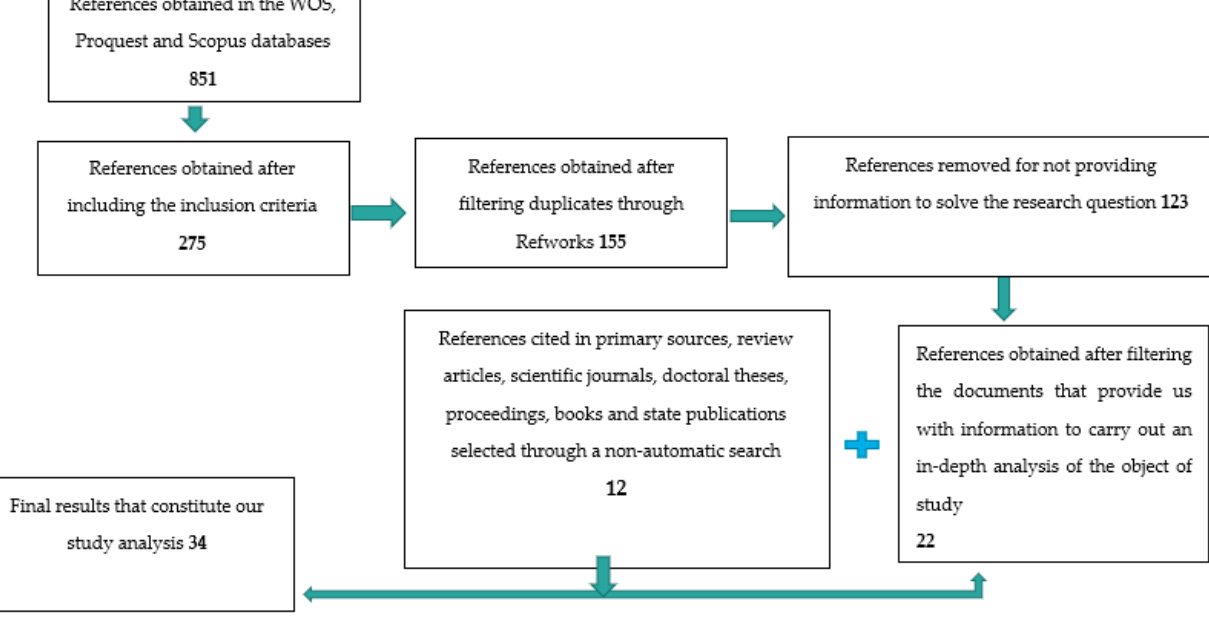
Figure 1. Summary of the workflow under review and number of items retrieved, deleted and selected. Source: own